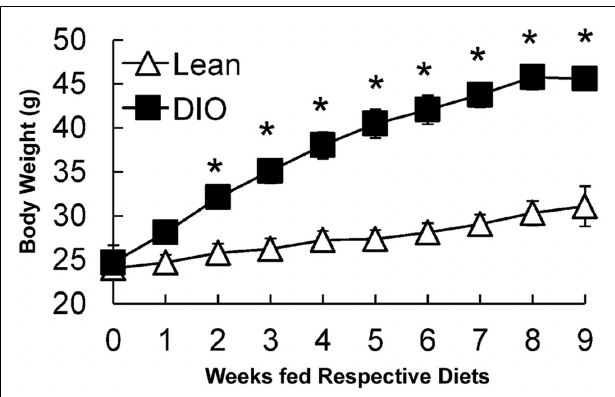
FIGURE 1 | Growth curves of lean (low fat, chow-fed) and DIO (HF-fed) mice starting at 10weeks of age for 9weeks. Data are represented as mean ± SEM. Asterisks denote significant differences compared to lean mice at the particular time point ( T -test), P < 0.05, n = 5 mice.